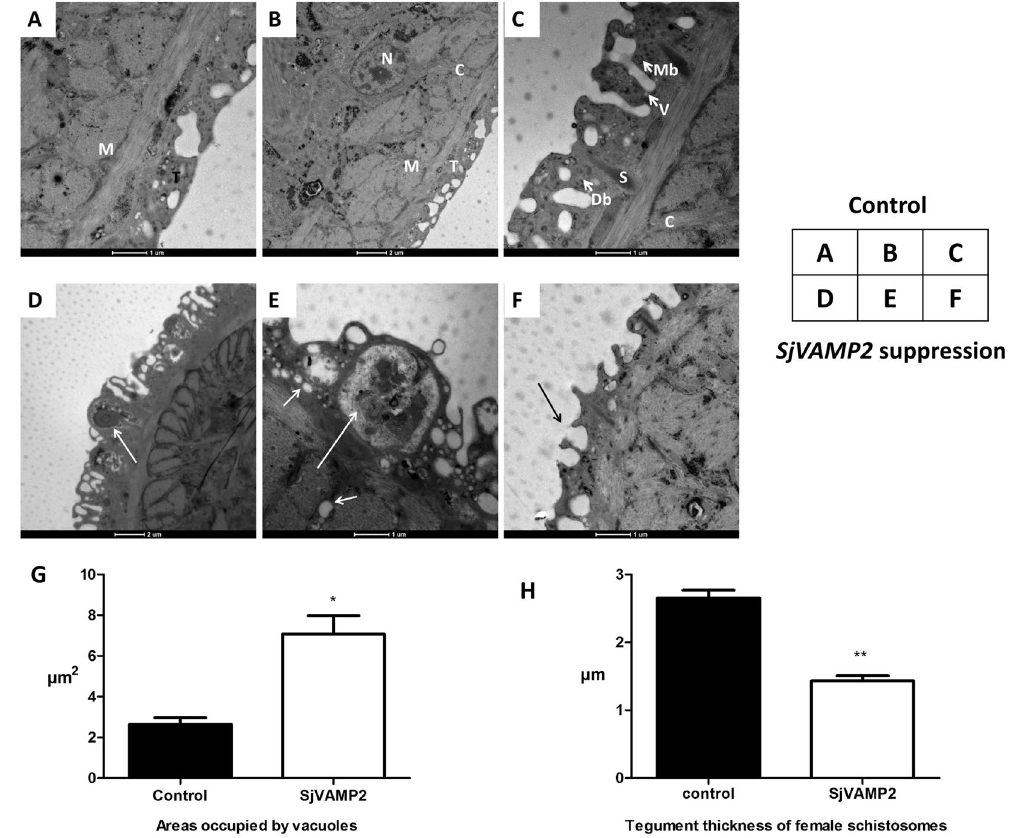
Figure 4. Transmission electron microscopy analysis of schistosomes after siRNA treatment. ( A , B , C ) Topography of S . japonicum in the control group, showing the whole tegument from the surface to the muscle layer. ( A ) The dorsal aspect of the female schistosome. ( B , C ) The dorsal aspect of the male schistosome. Tegument matrix (T), cytoplasmic bridge (C), nucleus of syncytium (N), spines (S), muscles (M) beneath the tegument, discoid bodies (Db), membranous bodies (Mb),vesicles (V) in the tegument matrix. ( D , E , F ) Topography of the tegument of S . japonicum after treatment with SjVAMP2 specific siRNA. ( D ) Emergence of enlarged membranous bodies with hepatalmemebrane in the tegument matrix of male worm (arrow indicated). ( E ) Male schistosome showing an irregular enlargement of sensory organelles in the tegument (large arrow), formation of quantities of vacuoles (small arrow). ( F ) Female schistosomes with decreased thickness of the dorsal medial tegument showing the failure to close the outer tegument invaginations (arrow indicated). ( G ) Three male worms were randomly selected and the areas occupied by vacuoles were measured by imageJ. ( H ) Three female worms were randomly selected and the thickness of the dorsal medial tegument was analyzed by